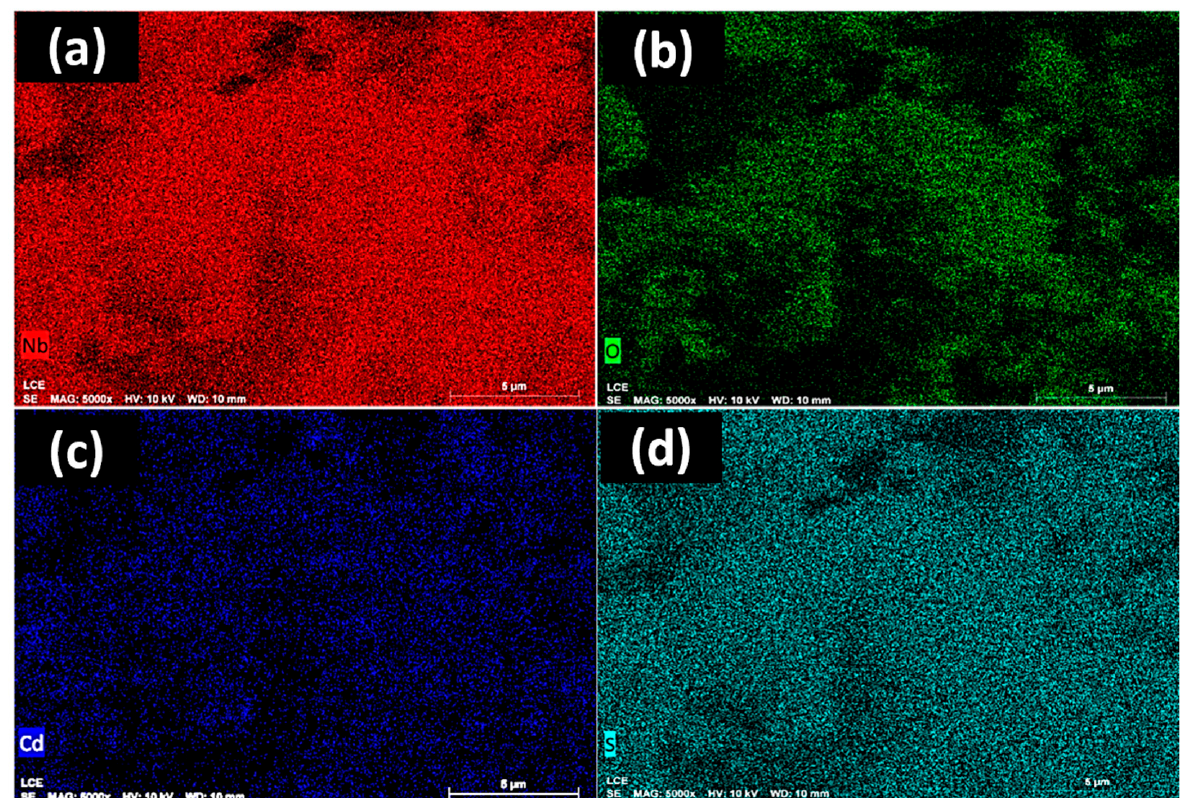
Figure 3. EDS mapping images for the elements: Nb ( a ), O ( b ), Cd ( c ), and S ( d ).